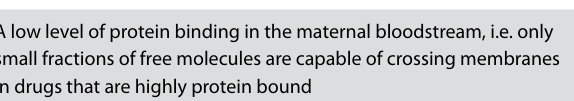
Table 2: The four characteristics of drug molecules which are most likely to cross the placental barrier 1,3,5,7,8 A high degree of fat-solubility, i.e. lipophilic molecules A low degree of ionisation, i.e. molecules which do not carry charges A low level of protein binding in the maternal bloodstream, i.e. only small fractions of free molecules are capable of crossing membranes in drugs that are highly protein